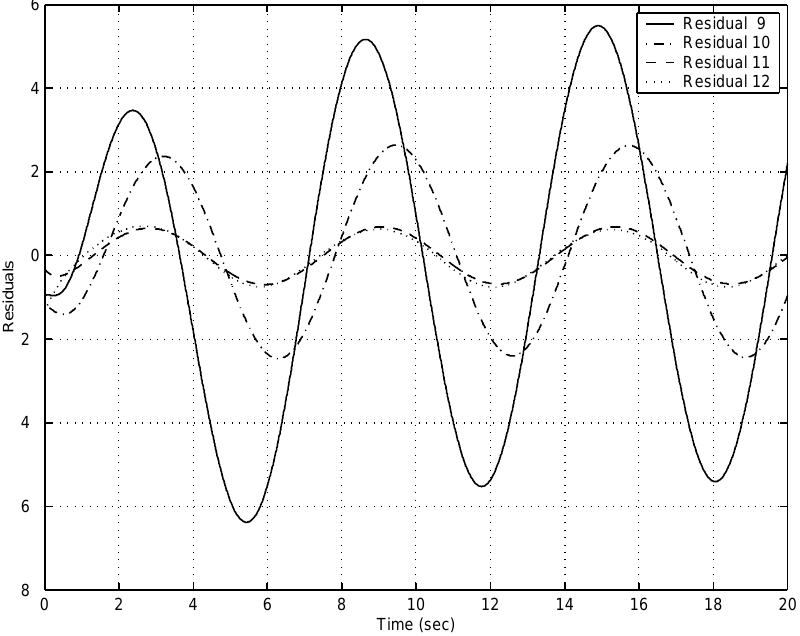
Fig. 15. Residuals 9–12 for 4 mode simulation with δ 1 = 0 . 01 .